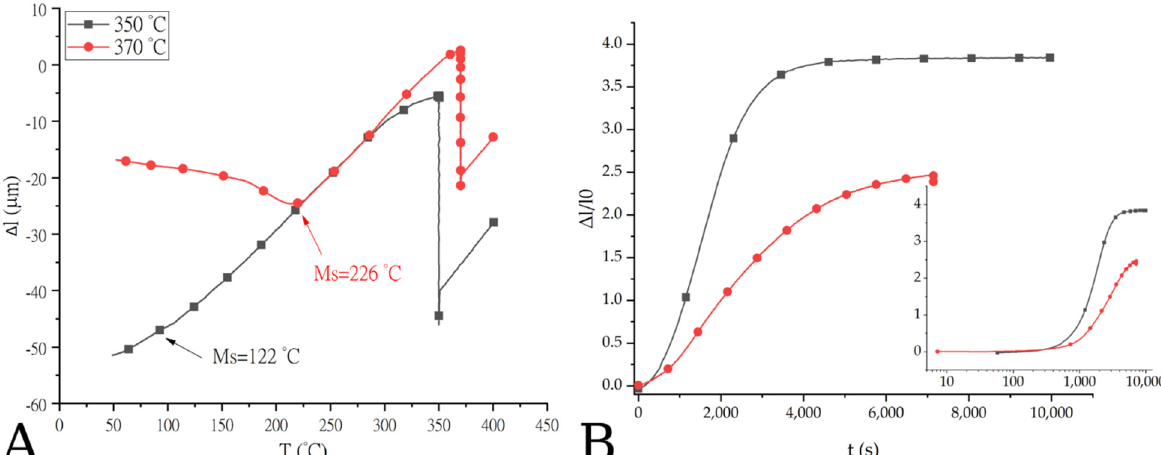
Figure 3. ( A ) Cooling branch of the dilatometric curve showing the change in length ( ∆ l) against temperature for the single-step austempering treatment ( B ) dilatometric curve showing the change in length with time. The insert in ( B ) better shows the incubation time for both bainite transformations.